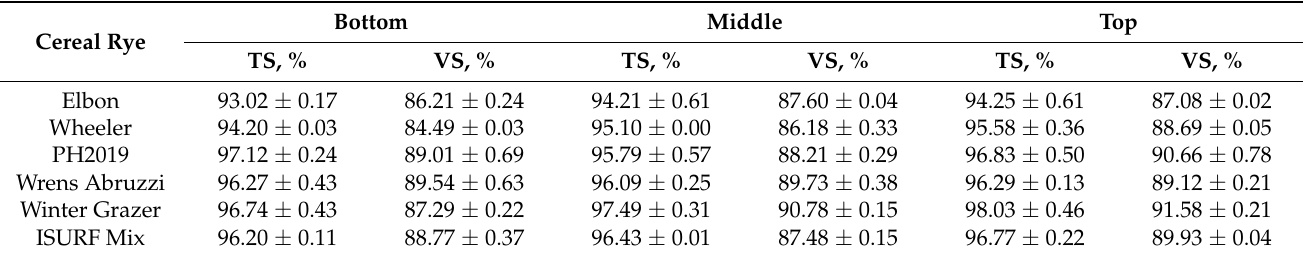
Table 1. Total Solids (TS) and Volatile Solids (VS) of cereal rye biomass (Average ± SE). Bottom Middle Cereal Rye